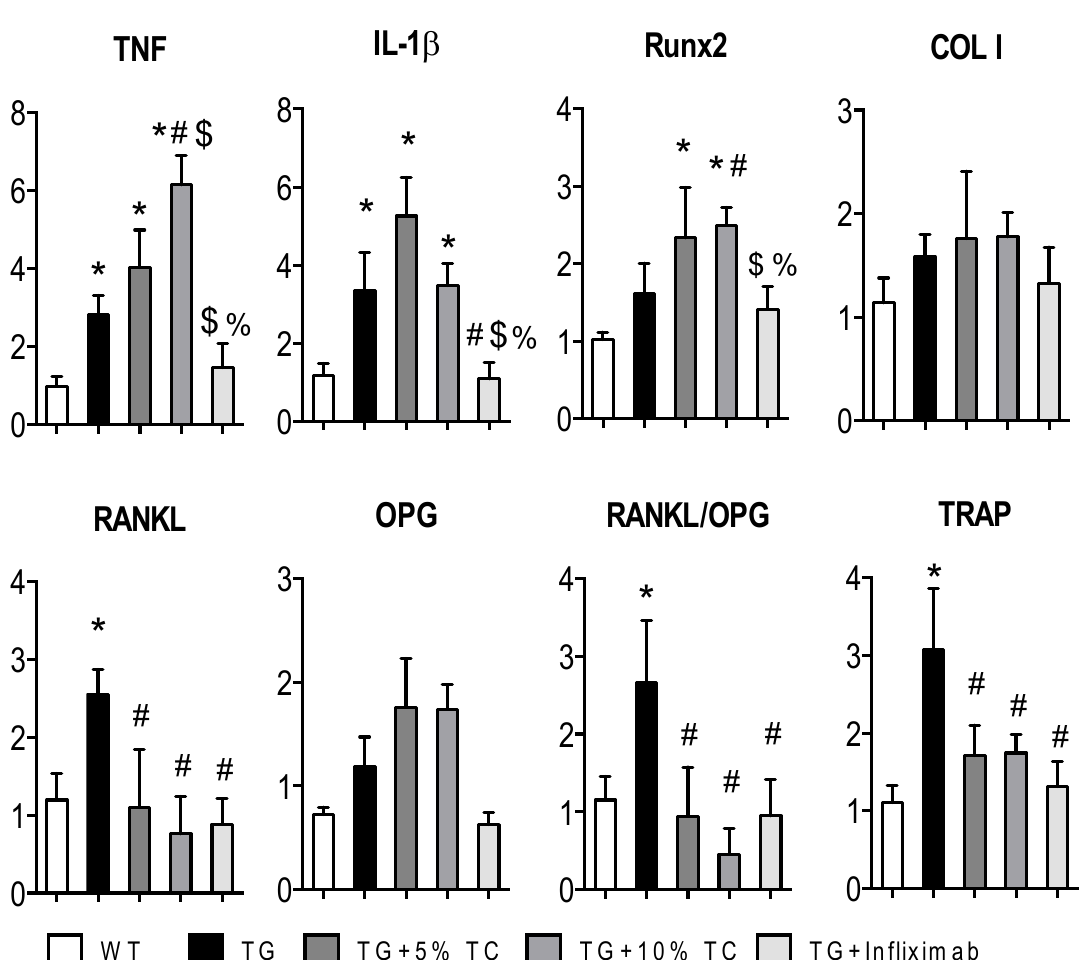
Figure 4. TC downregulated gene expressions of RANKL and TRAP . Total RNA was extracted from histological sections of metaphyseal area in each femur of WT, TG, TG + 5% TC, TG + 10% TC, and TG + infliximab mice. cDNA converted from total RNA was applied to measure relative transcript levels of TNF, IL-1 β , Runx2, COL I, RANKL , and TRAP that were normalized to GAPDH using RT-PCR. Values are means ( n = 4–8) ± SEM. *, p < 0.05 vs. WT; #, p < 0.05 vs. TG; $, p < 0.05 vs. TG + 5% TC; %, p < 0.05 vs. TG + 10% TC.